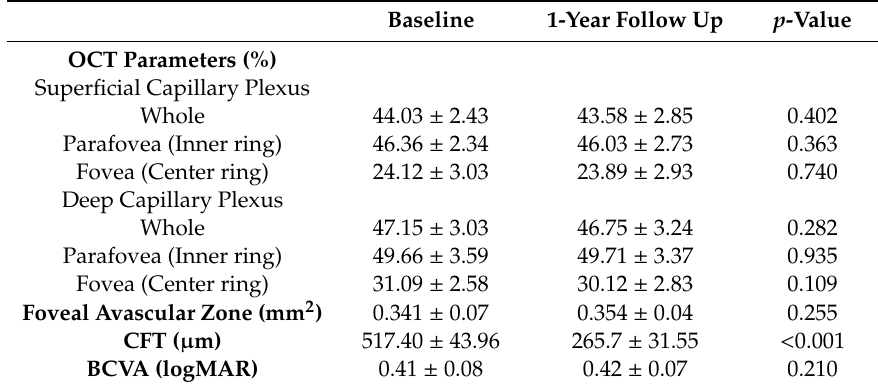
Table 3. Di ff erences in OCT angiography vessel density, central foveal thickness and BCVA before and after intravitreal injections in eyes with radiation maculopathy.